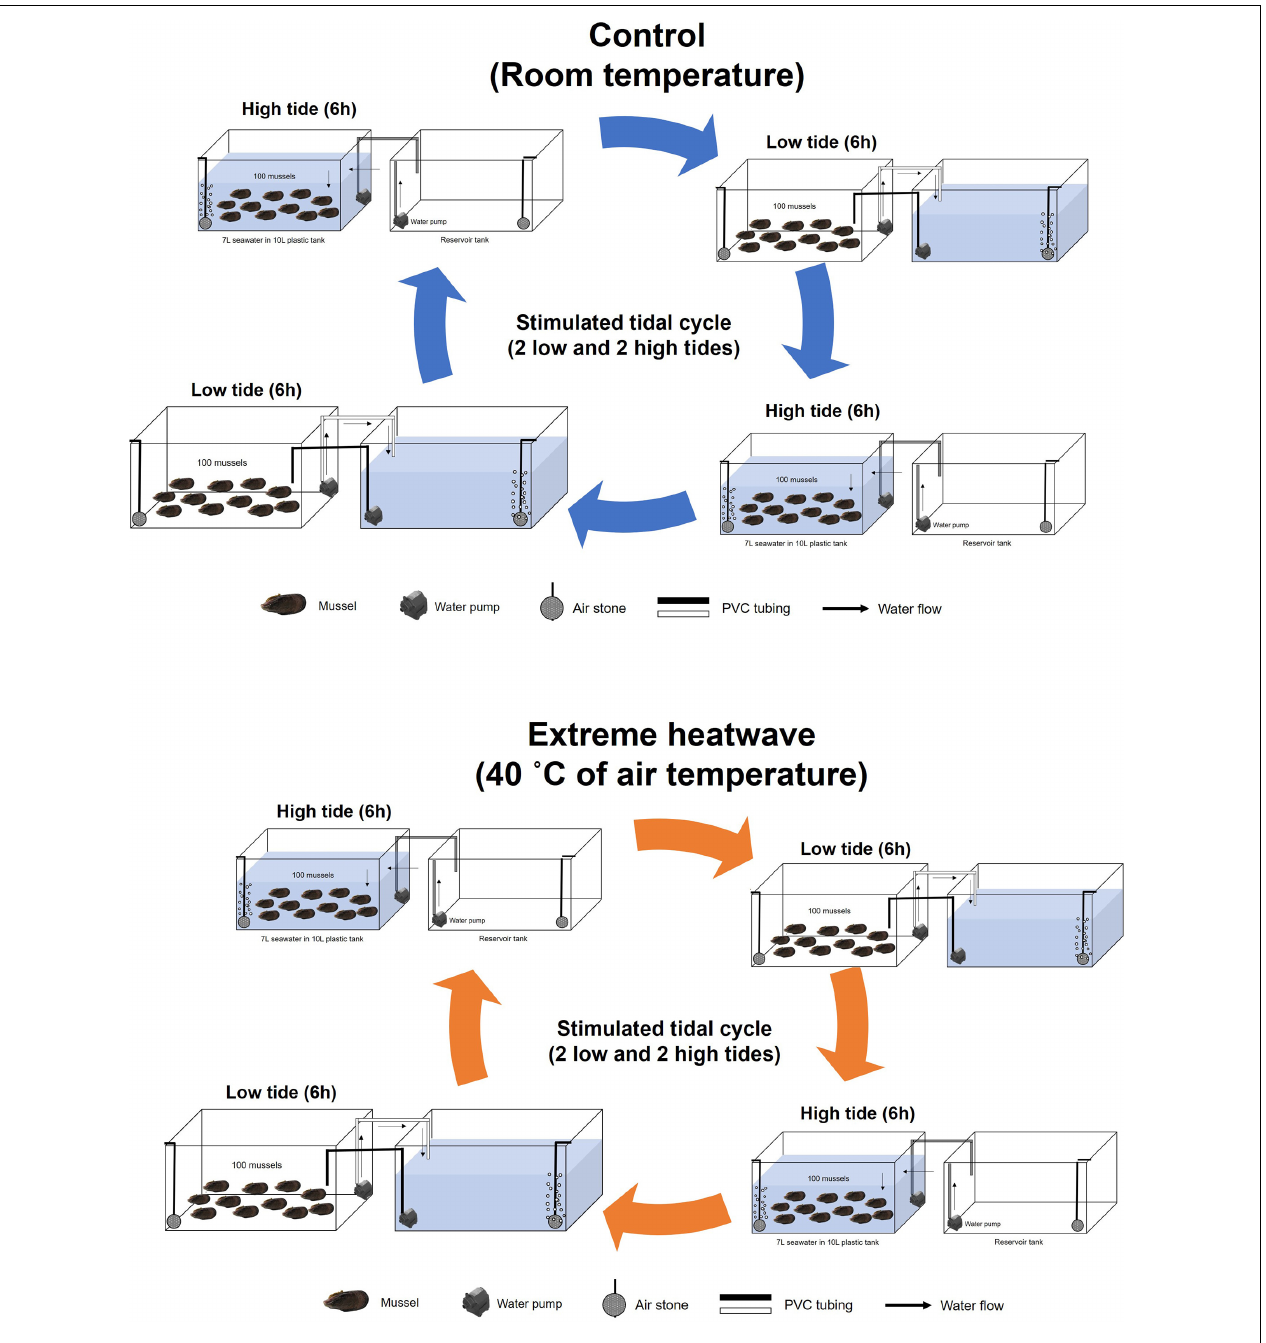
FIGURE 2 | Experimental setups used in the heatwave exposure